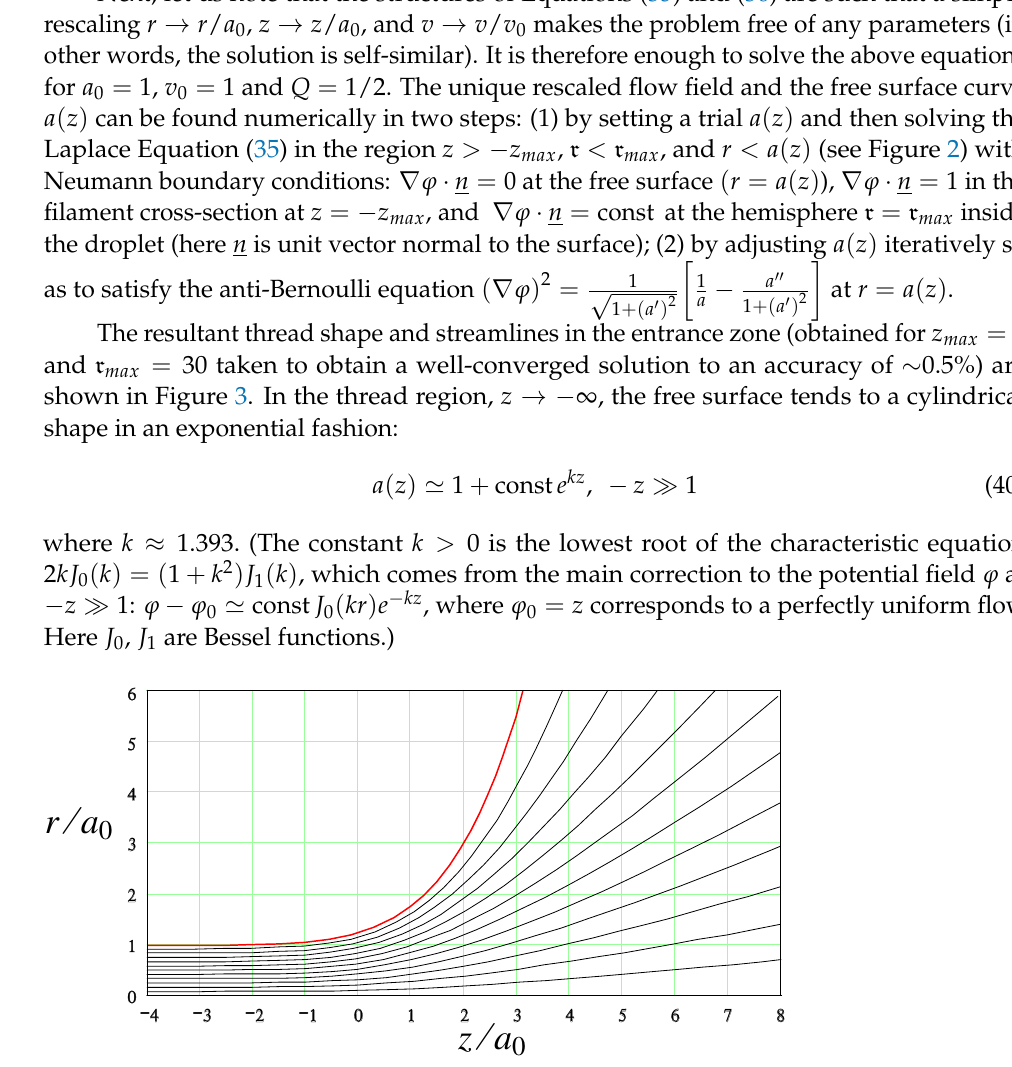
Figure 3. The free surface shape (red line) and streamlines (black curves) in the transition zone coming from Equations (5), (33), and (36) for a 0 =